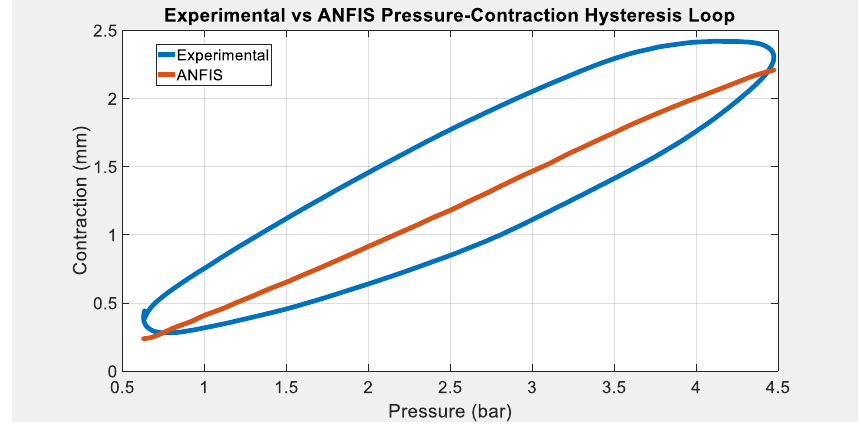
Figure 9. Experimental vs. ANFIS pressure-contraction using single input for the ANFIS.